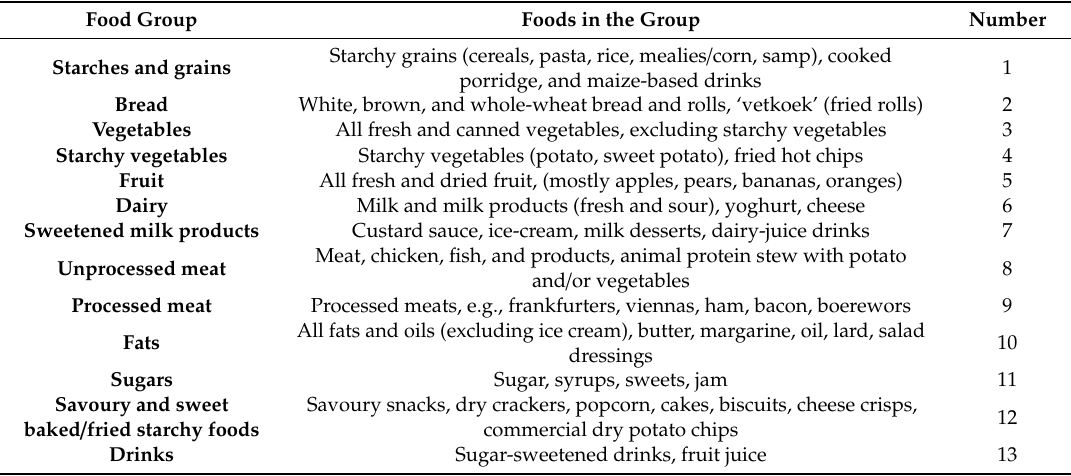
Table 1. The food group list used to identify dietary